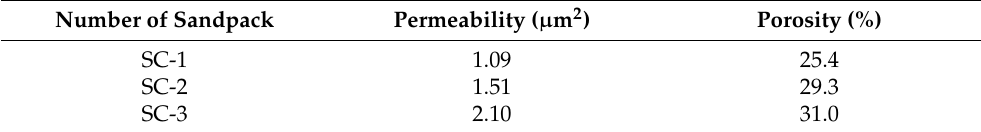
Figure 16. Flow chart of sandpack model. Table 4. Porosity and permeability of